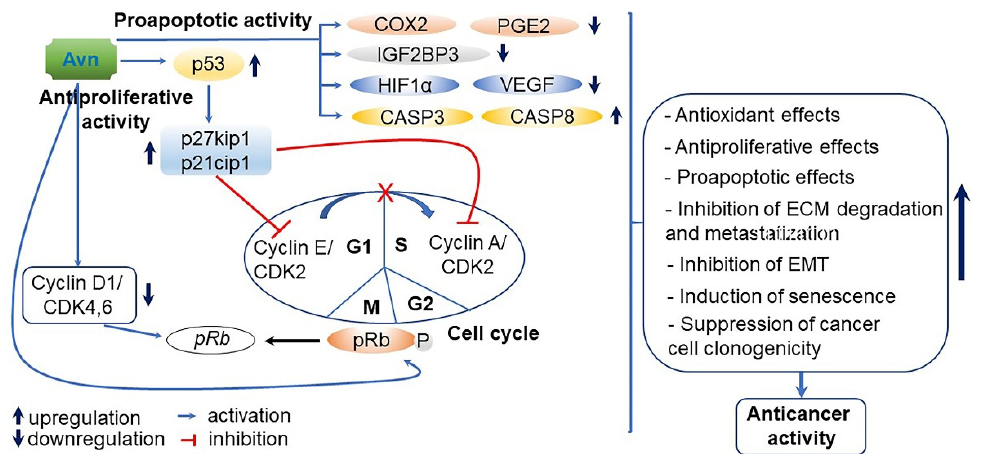
Figure 9. A proposed action mode of avenanthramides (Avns)-derived antiproliferative and proapoptotic activity. p53, and p27kip1 and p21cip1 activated by Avns treatment suppress the expression of cyclin E/ cyclin-dependent kinase 2 (CDK2) and cyclin A/CDK2 associated with cell cycle, and lead to the cell cycle arrest (G1 to S phase). In addition, Avns also downregulate the expression of cyclin D1/CDK4,6 and enhances phosphorylation of Rb protein (pRb) as a tumor suppressor. As a result, Avns cause cell cycle arrest of M phase. Based on these results, Avns play a vital role in the positive control of the cell cycle and in tumor progression [110,111]. With regard to proapoptotic activity, Avns upregulate caspase 3 (CASP3) and caspase (CASP8), while they downregulate insulin-like growth factor 2 mRNA-binding protein 3 (IGF2BP3), hypoxia-inducible factor 1-alpha (HIF1 α ), vascular endothelial growth factor (VEGF), cyclooxygenase 2 (COX2), and prostaglandin E2 (PGE2) in tumor cell lines [112]. Therefore, Avns reinforce anticancer effects through increased antioxidative, antiproliferative and proapoptotic effects, as well as induction of senescence, and inhibition of extracellular matrix (ECM) degradation and metastatization and epithelial-mesenchymal transition (EMT).